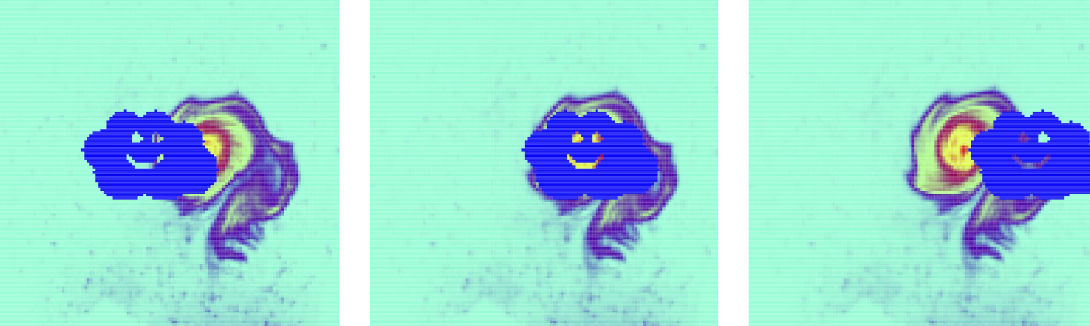
Figure 6. Example of an image sequence of the passive tracer concentration with missing observations. Left: first observation in the sequence, right: last